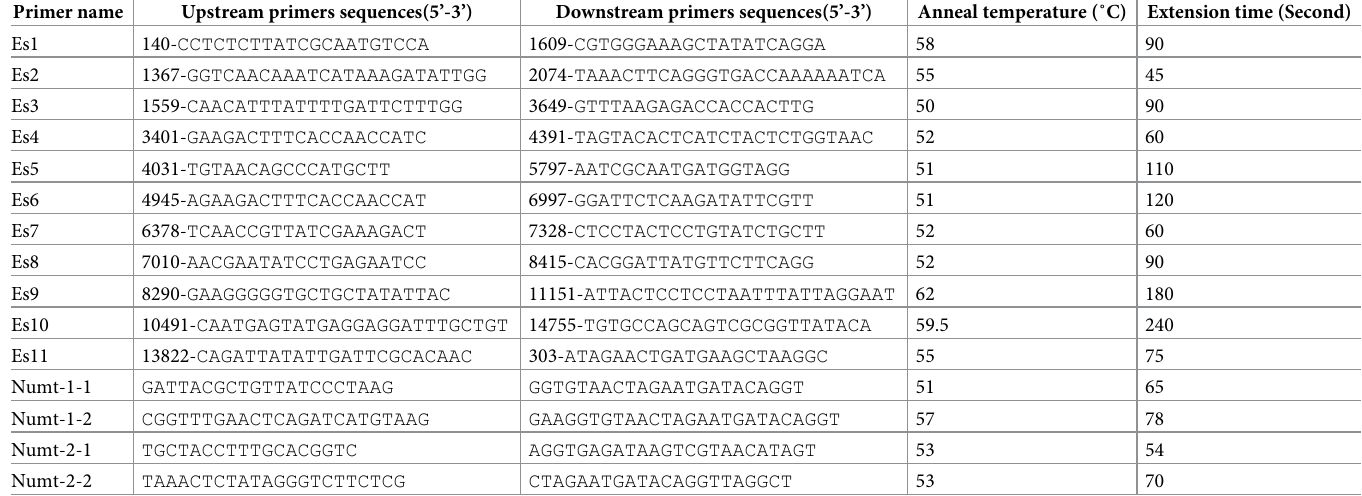
Table 1. Primers for the PCR amplifications of Episymploce splendens (Es) mito-genome and Numts. Primer